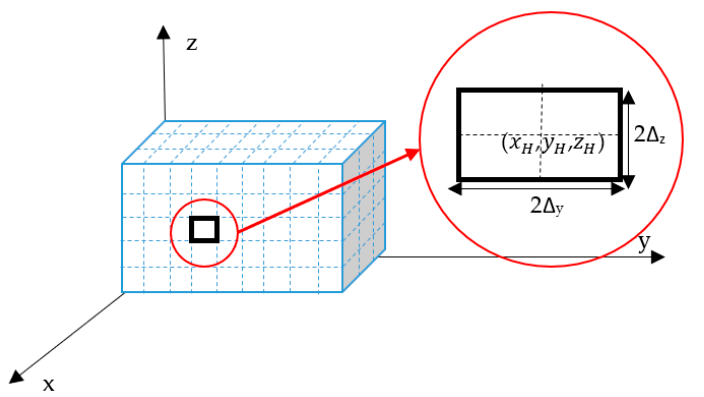
Figure 2. Sub-surface element in the face orthogonal to x axis and its coordinates and dimensions.